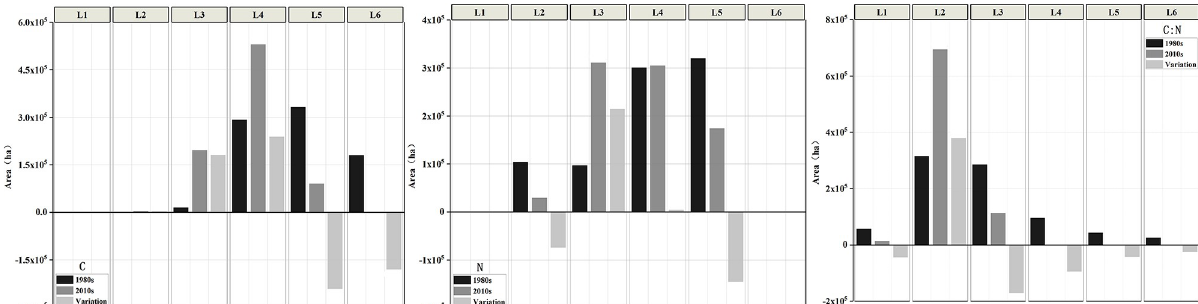
Fig 3. Area of C, N contents and C:N stoichiometry at each level.